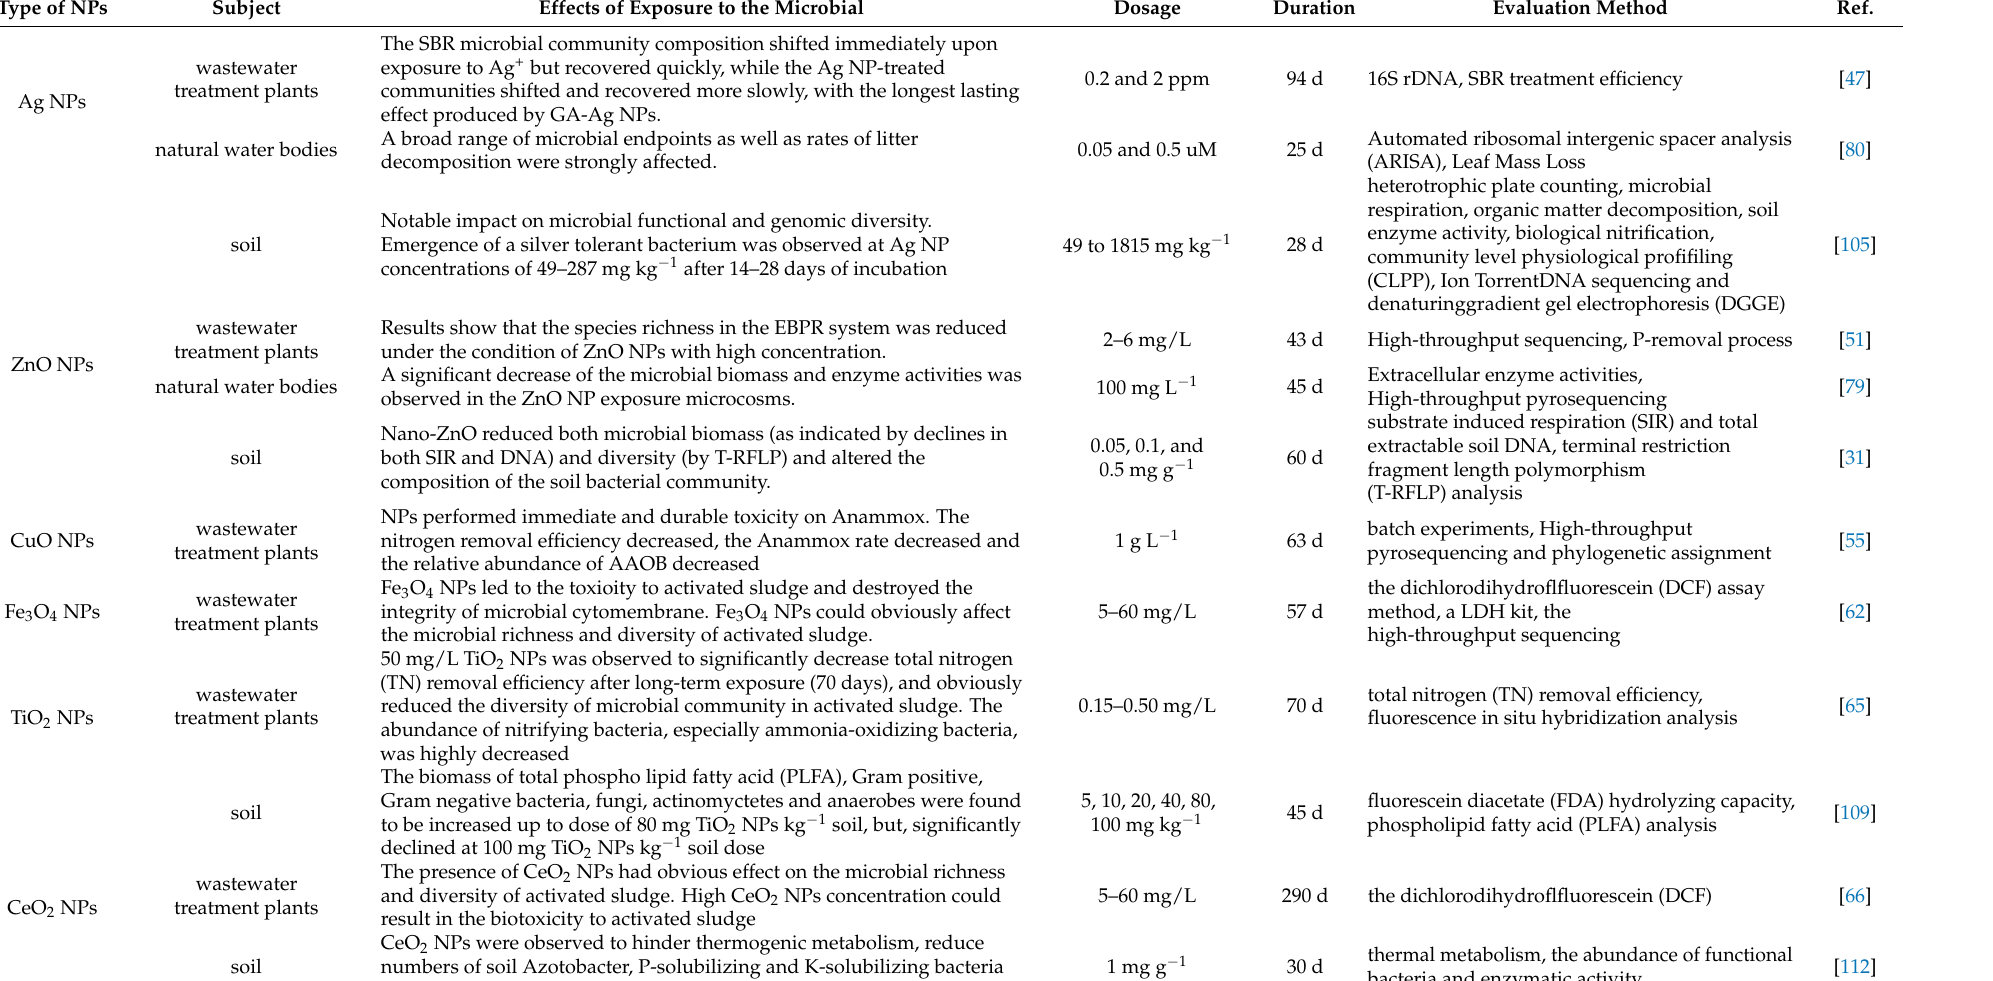
Table 1. Effect of NPs on microbial of different